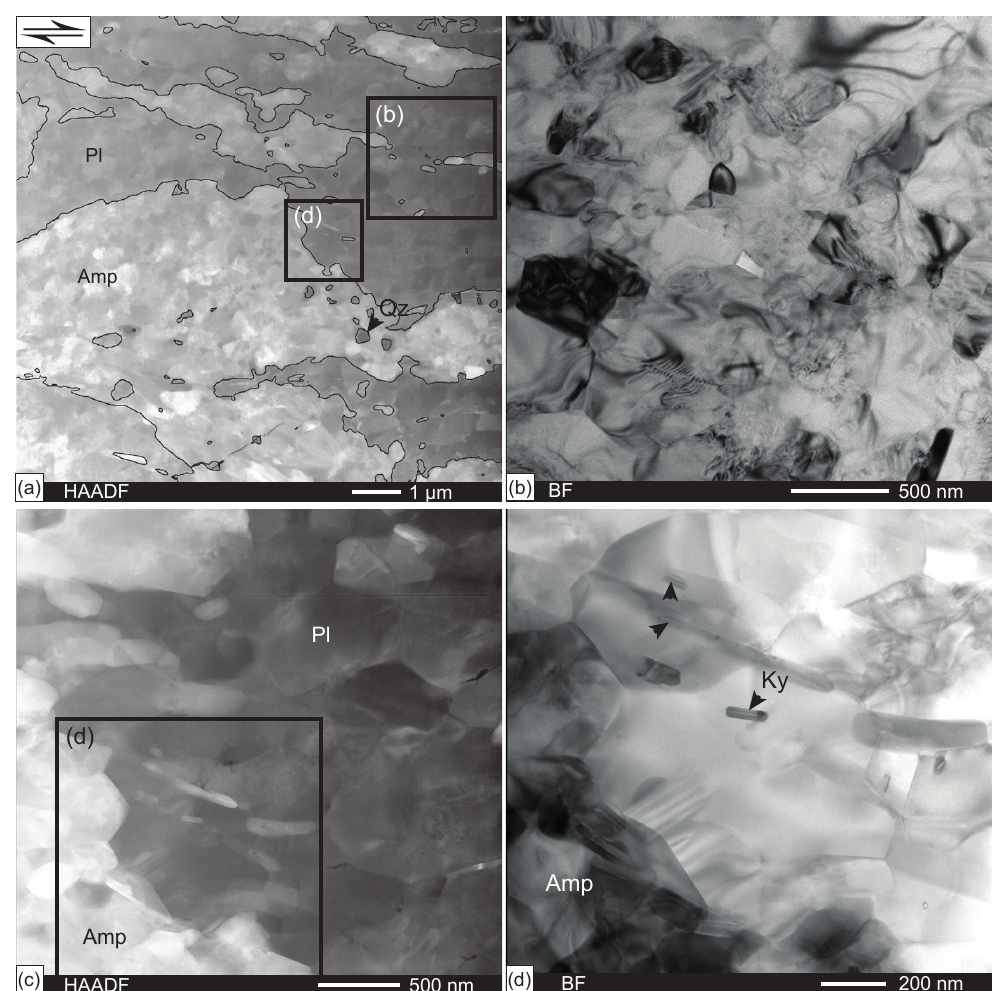
Figure 10. Nanostructure of shear bands in Maryland diabase sample. For sample 414, shear zone boundaries are horizontal and shear sense is dextral. (a) HAADF image, overview. Amp aggregates are traced with black lines for better visibility. Rectangles indicate areas shown in panels (b) and (d) . (b) BF-TEM image of small (usually ≤ 600nm) plagioclase grains with low internal defect densities. Grain boundaries are tight and porosity is scarce. (c) HAADF image, overview. Black rectangle indicates area shown in panel (d) . (d) BF-TEM image of a few Ky and Amp grains growing between Pl grains. The size of all phases is a few hundred nanometers, and grains have a low internal defect